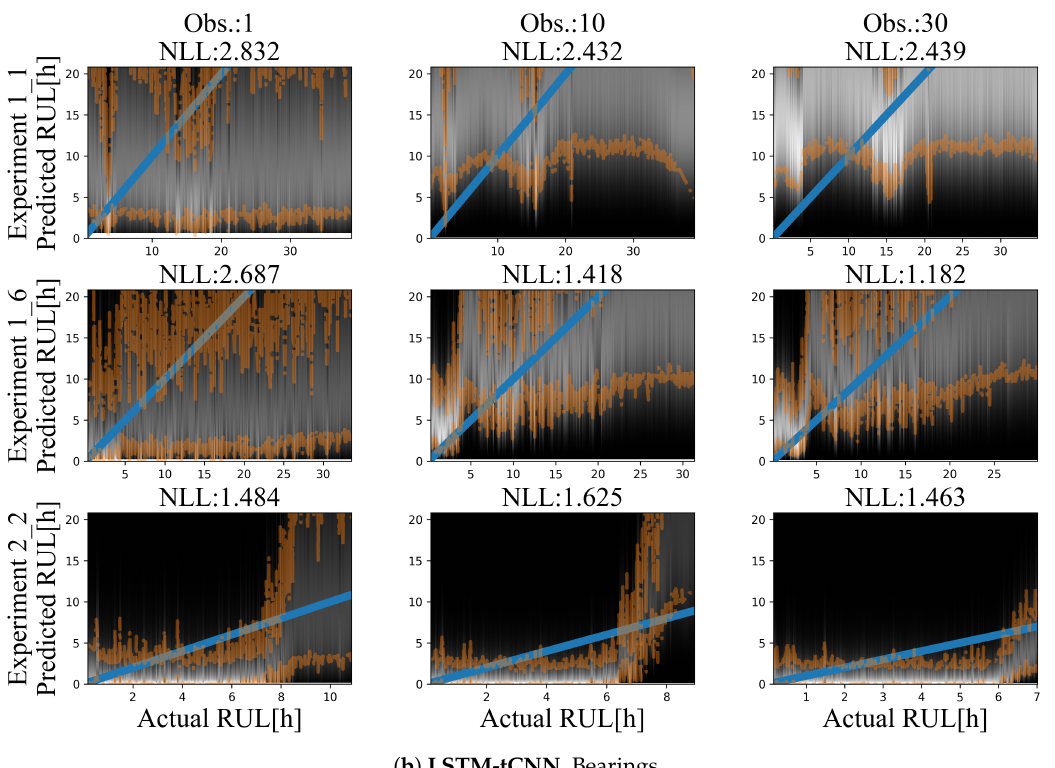
Figure 10. Results on the bearing dataset using ( a ) LSTM-tCNN (top) and ( b ) LSTM-tCNN (bottom). The blue line corresponds to the correct RUL assuming constant linear degradation. The orange lines correspond to the 10% and 90% quantiles of the predictions. Table 5. MAPE and Negative Log Likelihood (NLL) errors for test-set experiments for the bearings dataset. For both GNN-tCNN and LSTM-tCNN 15 observations over a sequence of 2000 s (or 200 segments) were used. For the simple MLP method only a single observation was used for prediction. Best values for each metric are marked in bold. Please refer to the main text for further